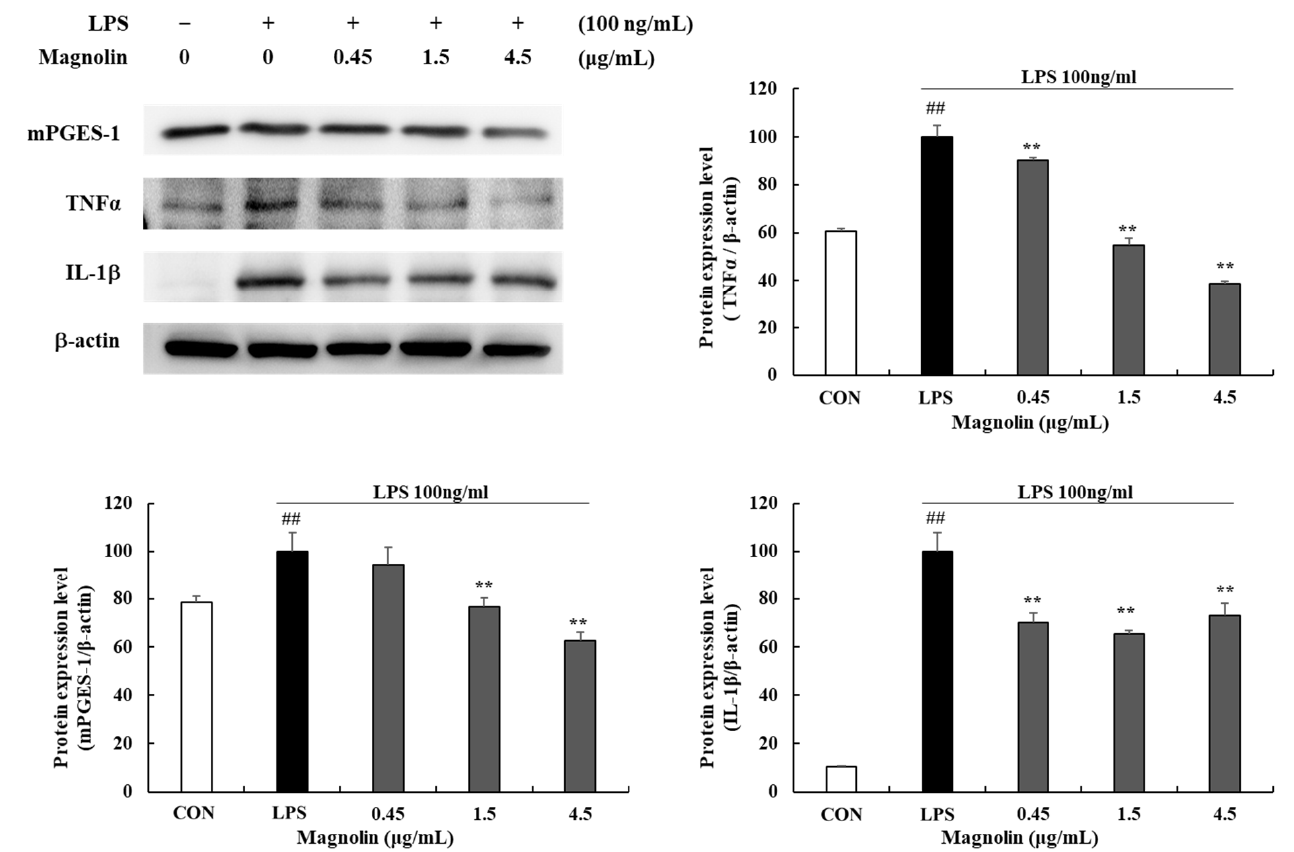
Figure 5. Effects of magnolin (0.45, 1.5, and 4.5 μg/mL) on the production of Inflammatory mediators in LPS-stimulated RAW 264.7 cells. Magnolin and 100 ng/mL of LPS were added, but not to the vehicle control group, and incubated at 37 °C for 24 h. Protein expression levels of TNF-α, IL-1β and mPGES-1 were detected by Western blot. The protein band density was measured utilizing ImageJ software. β-actin was used as a control. Values represent means ± standard deviation. ## p < 0.01 vs. Vehicle control group; ** p < 0.01 vs. LPS-activated control group.